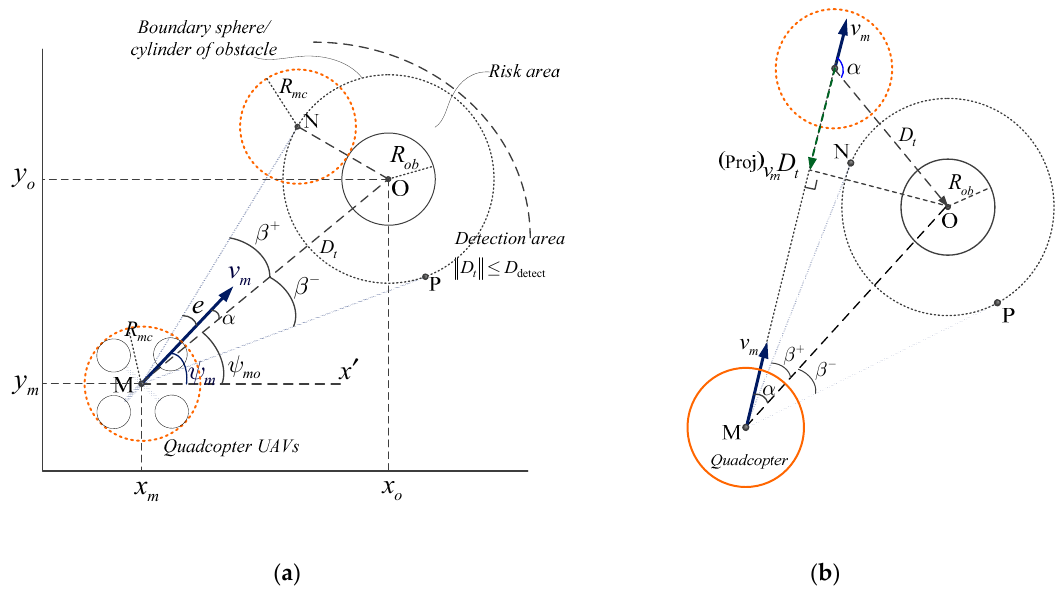
Figure 3. The geometrical relations of the quadcopter and an obstacle: ( a ) Fastest direction for collision avoidance; ( b ) The completion of collision avoidance.